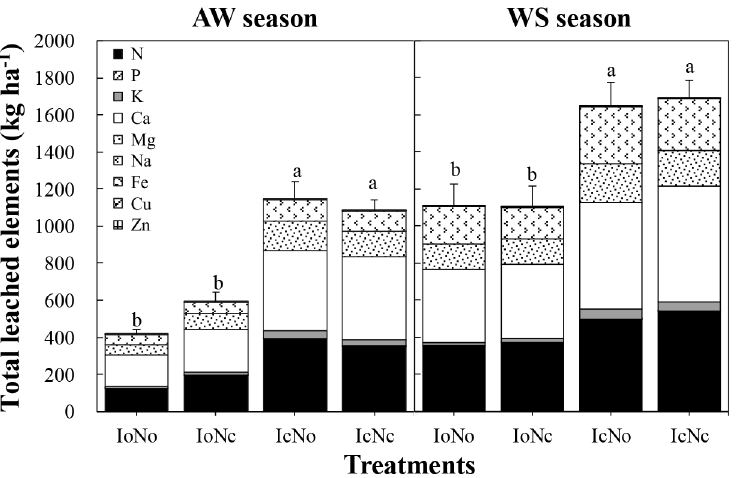
Fig 6. The total leached amounts of mineral elements under different treatments in the autumn-winter (AW) and winter-spring (WS) seasons. Treatments codes are the same as in Table 1. Bars represent standard errors (n = 4). The same letter in the same cropping season indicates no significant difference (P =